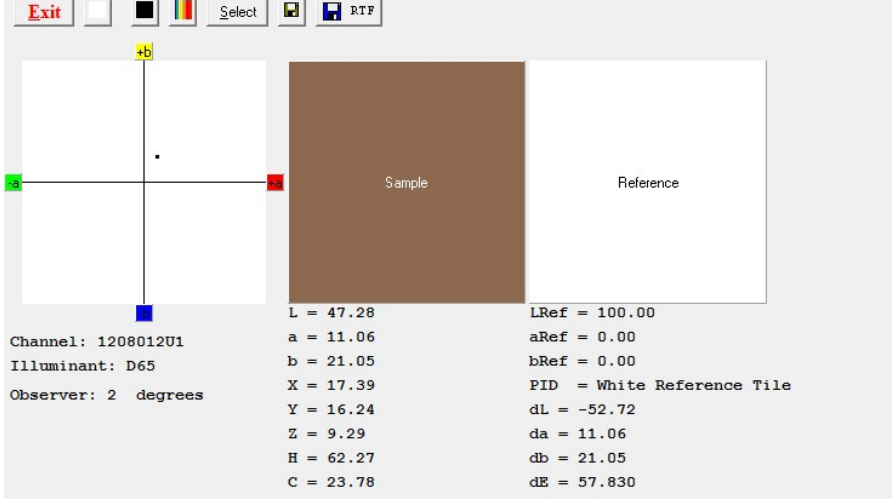
Figure 4. An example of color measurement results, including L , a , b CIELab parameters.